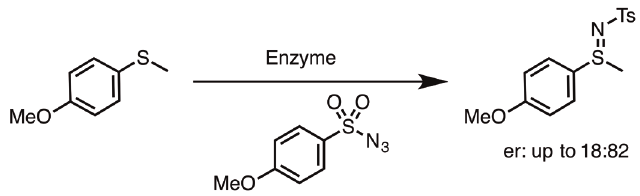
Figure 39 - Nitrogen transfer reaction using P450